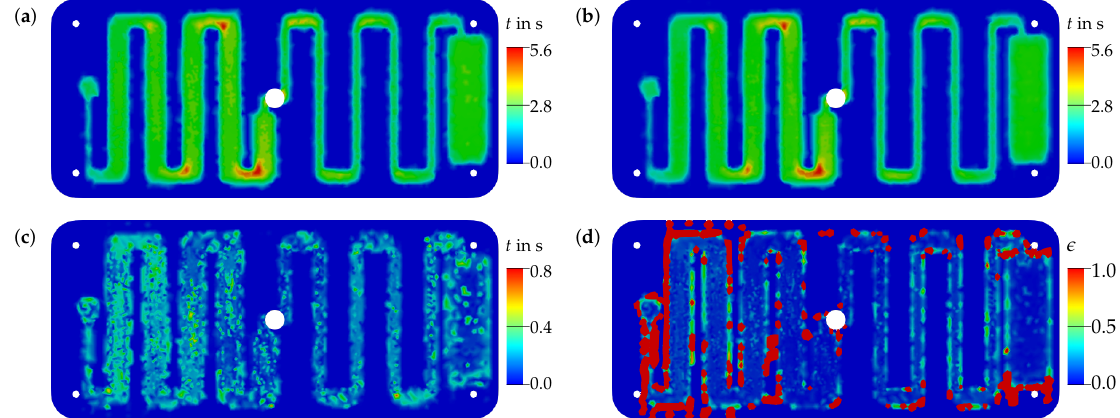
Figure 8. Comparison of t m for sample 11. ( a ) Numerical result of full-scale simulation; ( b ) predicted result by Random Forest; ( c ) absolute difference; ( d ) relative error (values with error >1 are indicated by the color